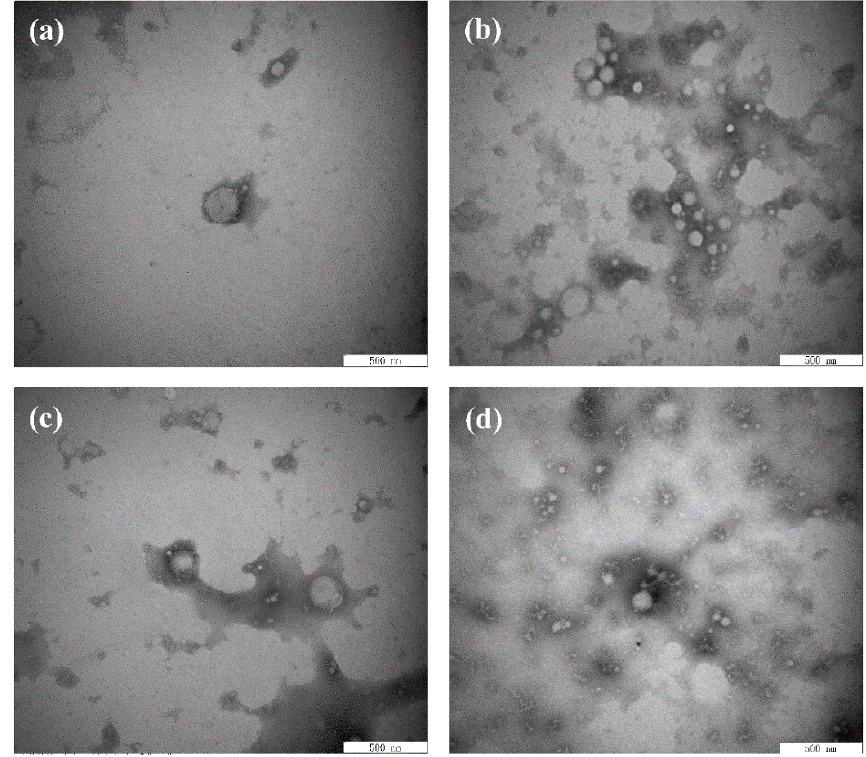
Figure 4. Transmission electron microscope images of the BBPI ( a ), BBPI-EGCG ( b ), BBPI-G ( c ), and BBPI-G-EGCG ( d ) of prepared oil-in-water emulsions.